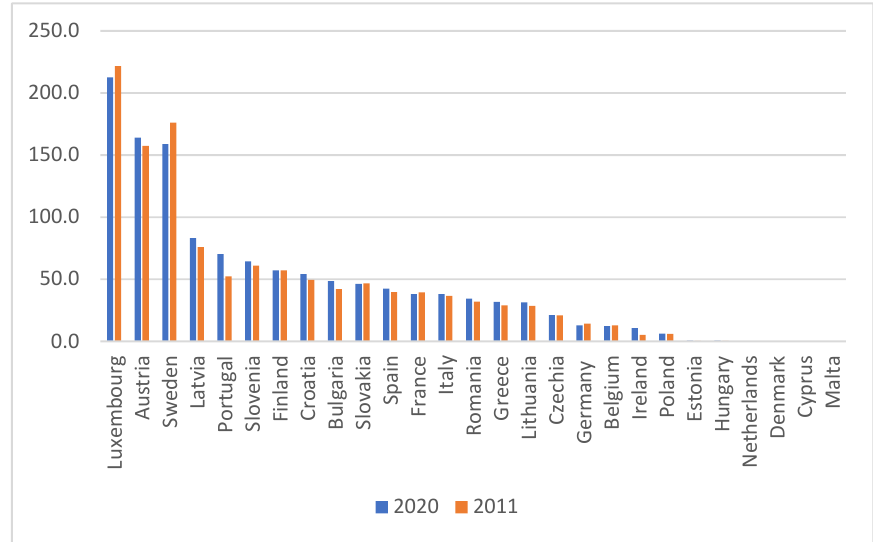
Figure 3. Energy production from renewable sources (hydro energy in megawatts per 100.000 population).